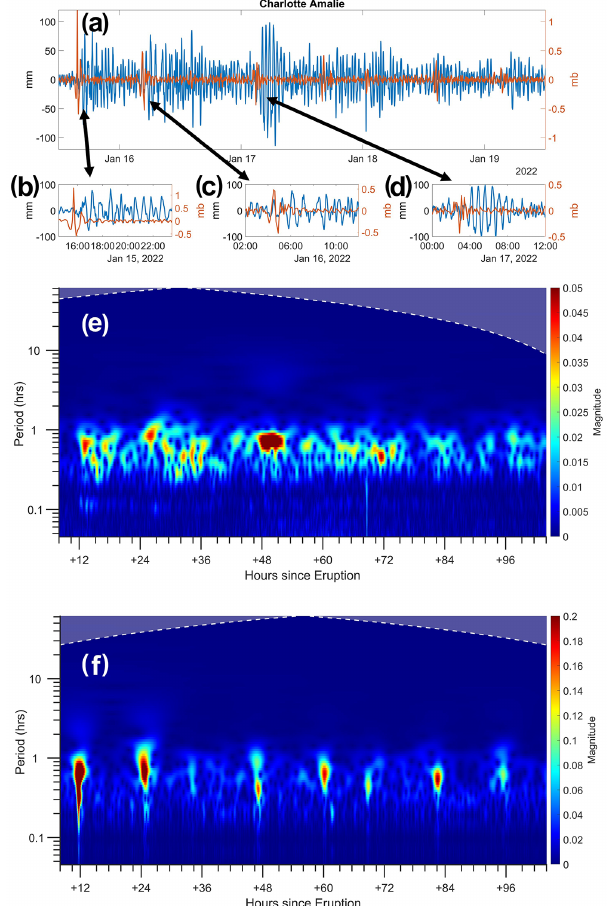
Figure 6. VMTs at Charlotte Amelie (NOAA gauge 9751639) in the Caribbean: (a) residual WL variability (blue) and P A (orange) from 15:00UTC to 19 January 2022; (b–d) expanded views of (a) at the times of the first, second, and fourth P A spikes; (e, f) CWT scalograms of the WL and P A records in (a)